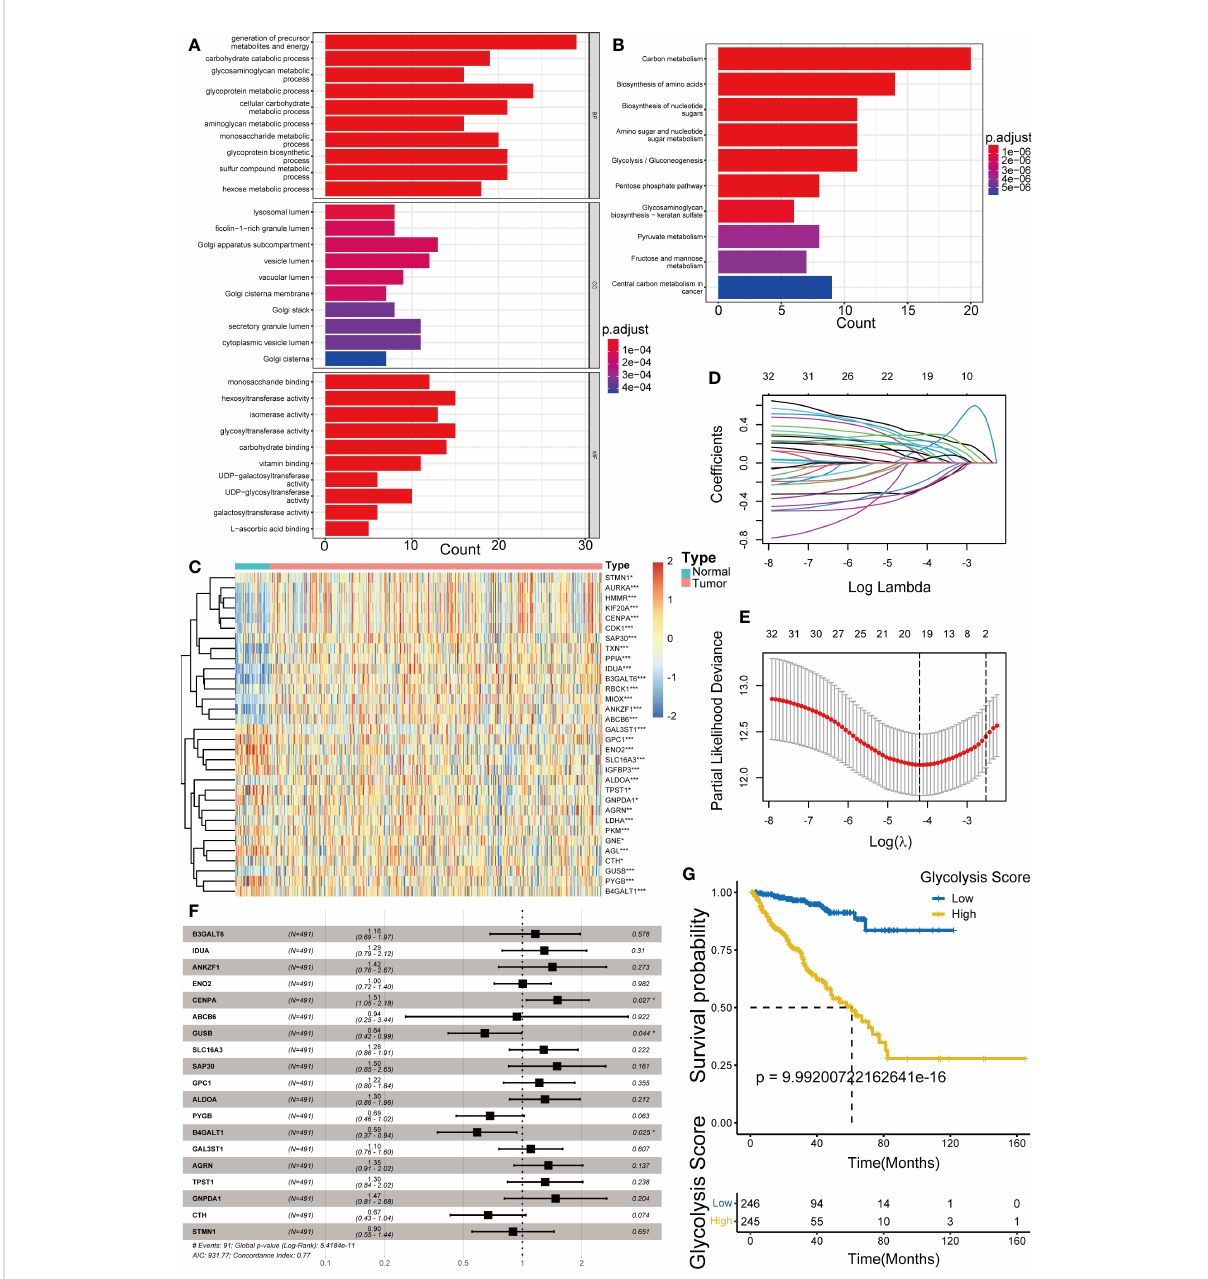
FIGURE 1 Establishment of Glycolysis Score. (A, B) Gene Ontology (GO) and Kyoto Encyclopedia of Genes and Genomes (KEGG) enrichment analysis of the glycolysis-related DEGs. (C) Heatmap showing the difference of prognostic glycolysis-related genes (GRGs) between tumor and normal tissues. (D, E) The least absolute shrinkage and selection operator (LASSO) Cox regression analysis for the prognosis-related GRGs. (F) The multivariable Cox regression analysis of 19 GRGs in the Glycolysis Score. (G) Kaplan – Meier analysis for disease-free survival (DFS) of patients from TCGA-PRAD between groups de fi ned by the Glycolysis Score. *p< 0.05; ***p<